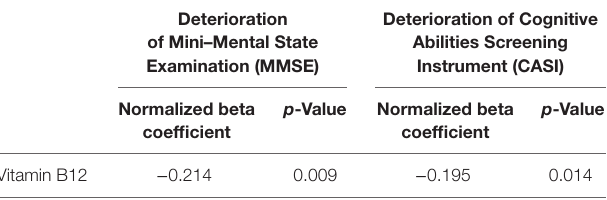
TaBle 2 | Multivariable regression model of the association between high vitamin B12 level and deterioration of cognitive